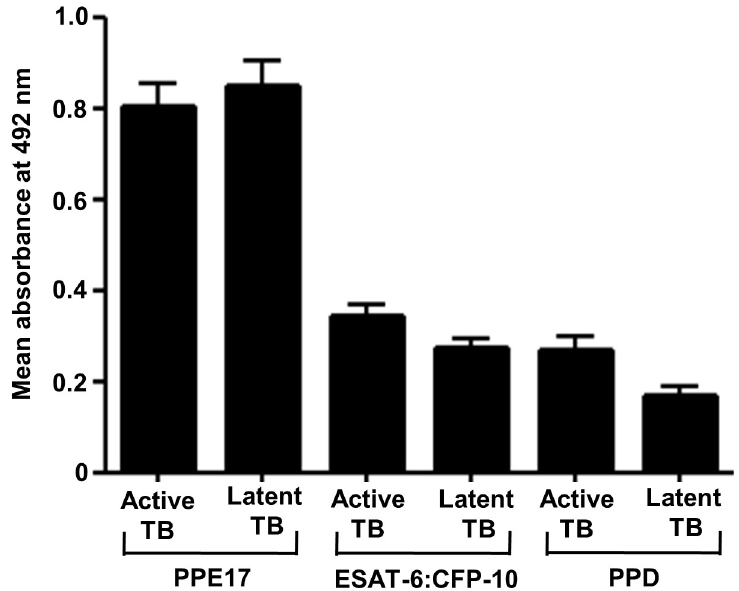
Fig 3. PPE17 elicits stronger antibody responses in active TB and LTBI compared to ESAT-6: CFP-10 and PPD. (A). Antibody responses to M . tuberculosis antigens PPE17, ESAT6:CFP10 and PPD were compared for LTBI individuals and active TB patients following ELISA. Results shown are in mean ±